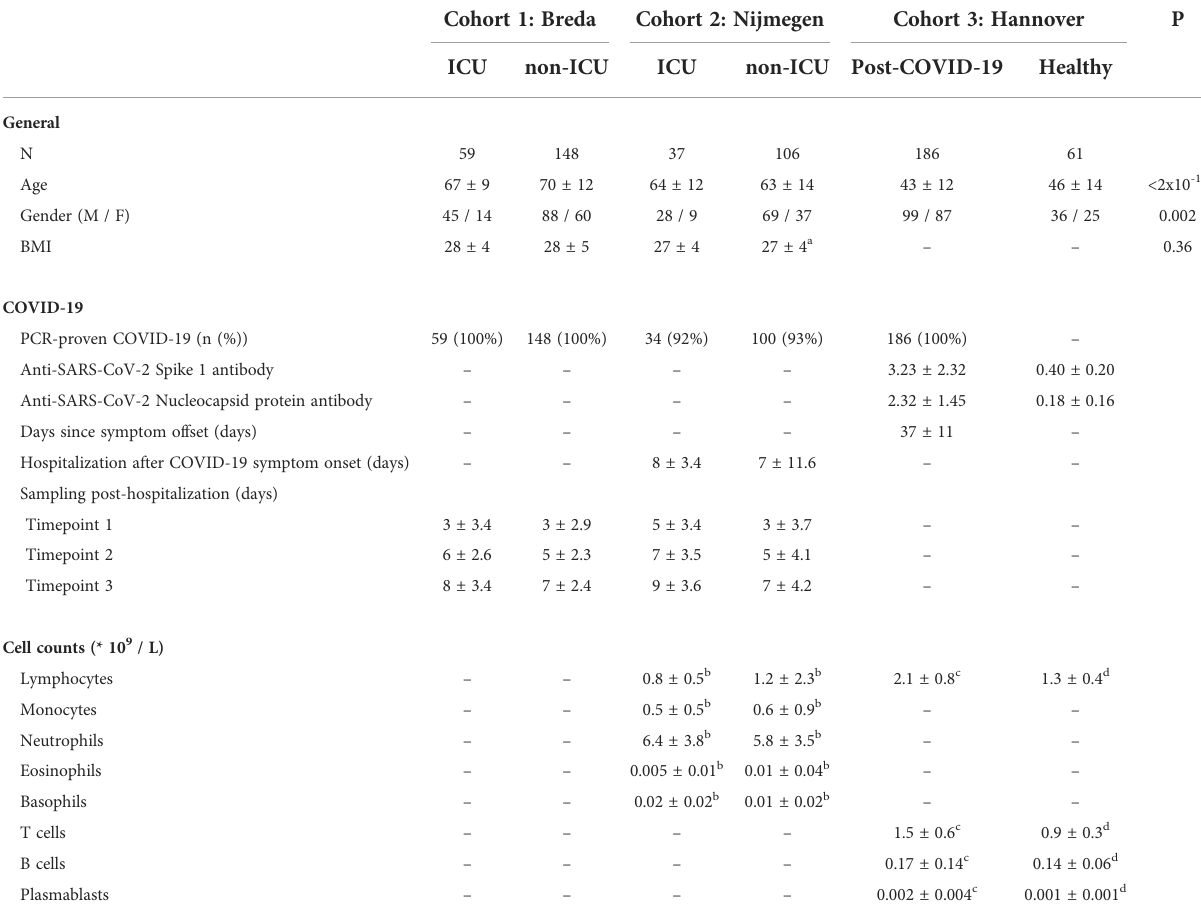
TABLE 1 Quality assessment of individual cohort